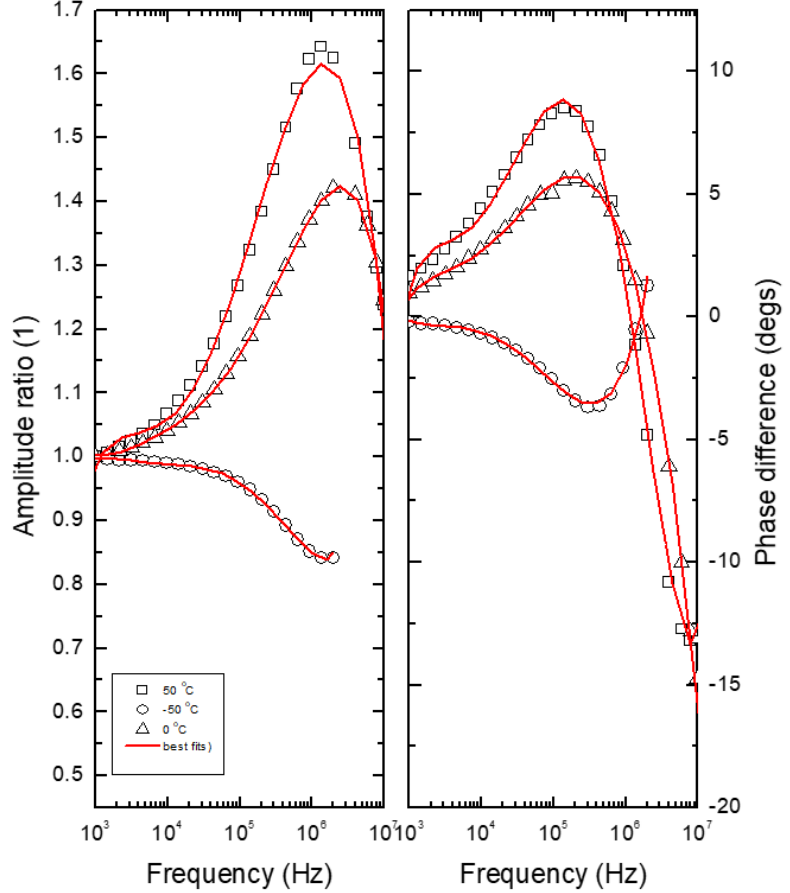
Figure 8. PTR experimental results (points) for sample#3 in three different temperatures: − 50 °C, 0 °C and 50 °C. Additionally, the best fittings are presented as solid lines using Equation (8).